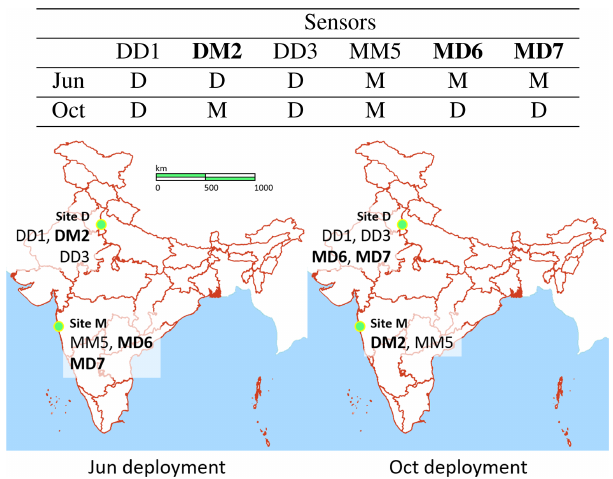
Figure 4. A schematic showing the deployment of the six LCAQ sensors across site D and site M during the two deployments. The sensors subjected to the swap-out experiment are presented in bold. Credit for map sources: the outlines of the Indian states in red are taken from QGIS 3.4 Madeira with other highlights (e.g., for oceans) and markers being added